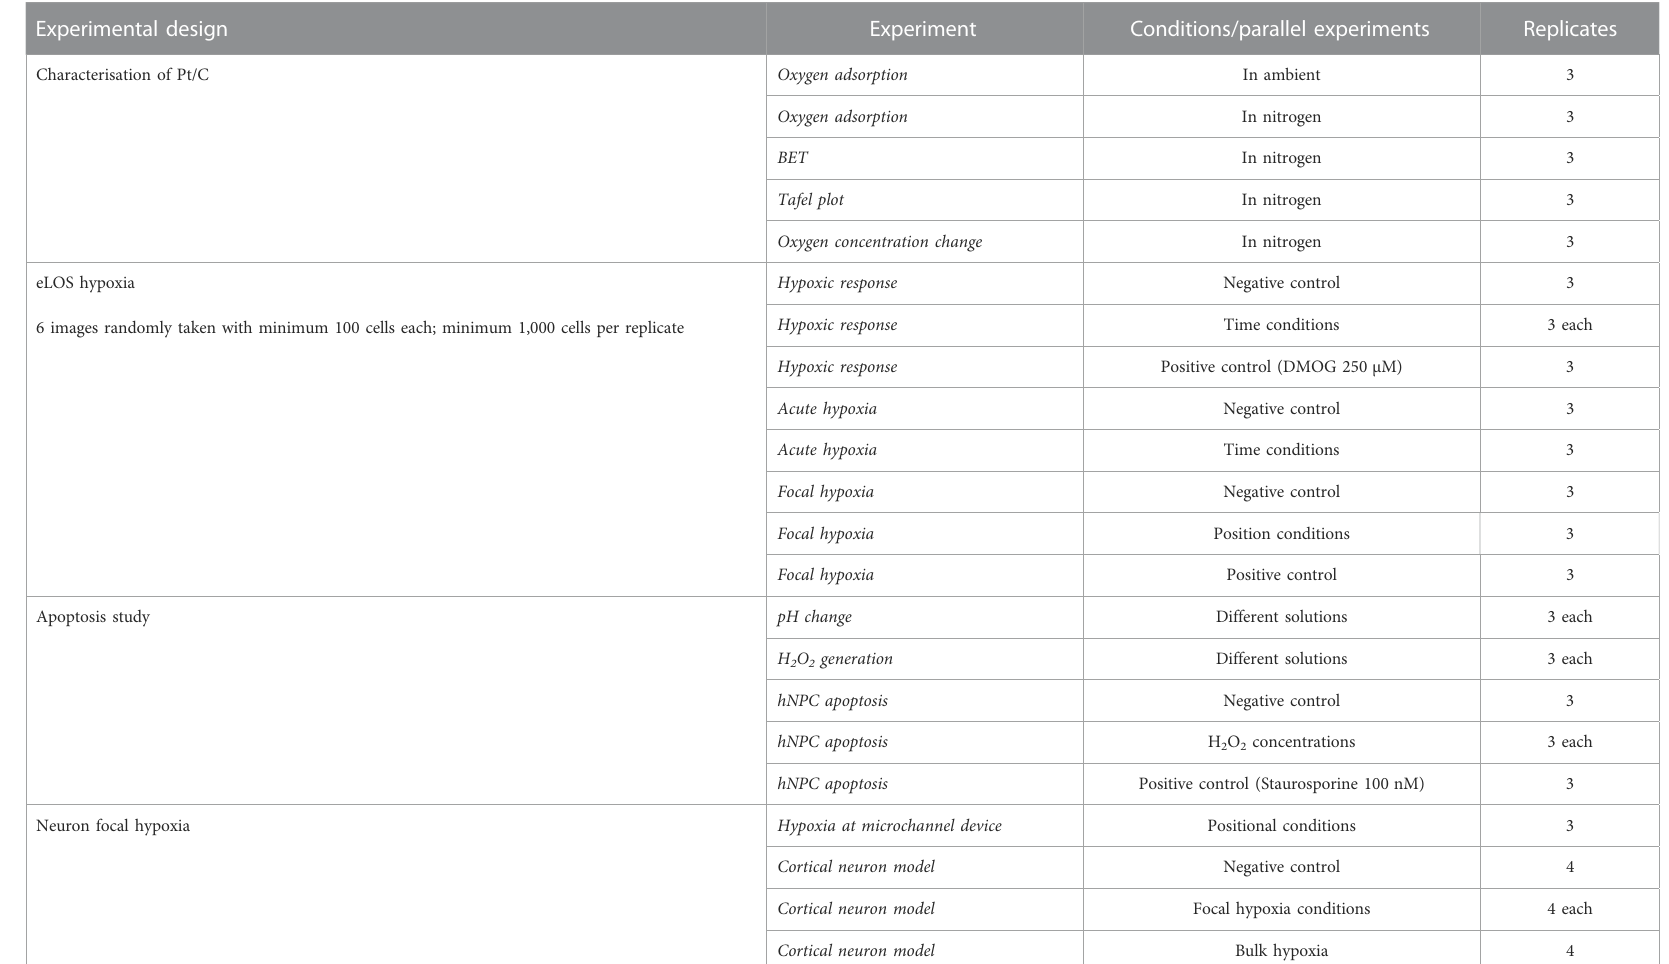
TABLE 2 Experimental